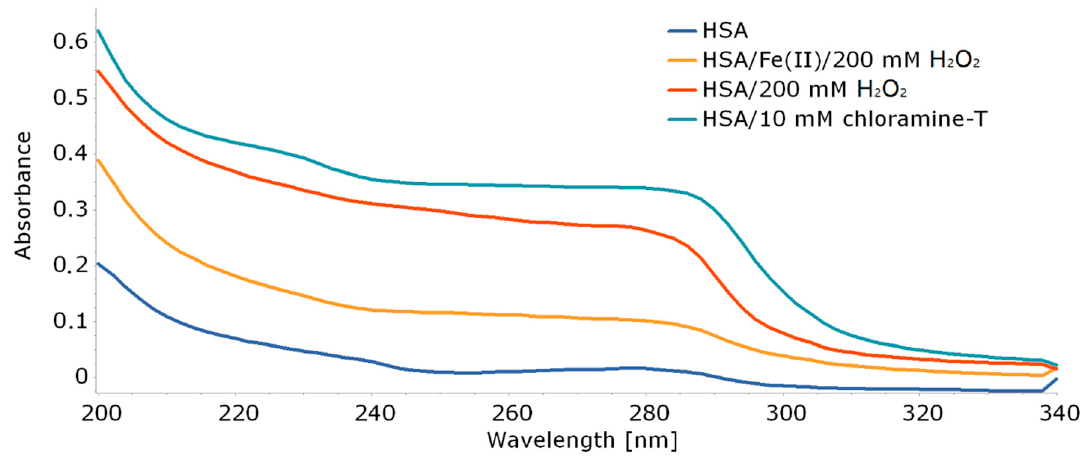
Figure 8. Absorption spectra of nonmodified HSA and HSA stressed with di ff erent stress factor. There are visible changes in the absorption spectrum for HSA oxidized with various stress